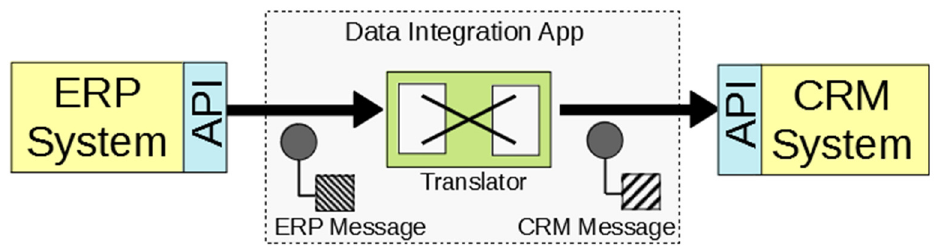
Figure 4. EIP Translator (on the basis of [14] (p. 86)).